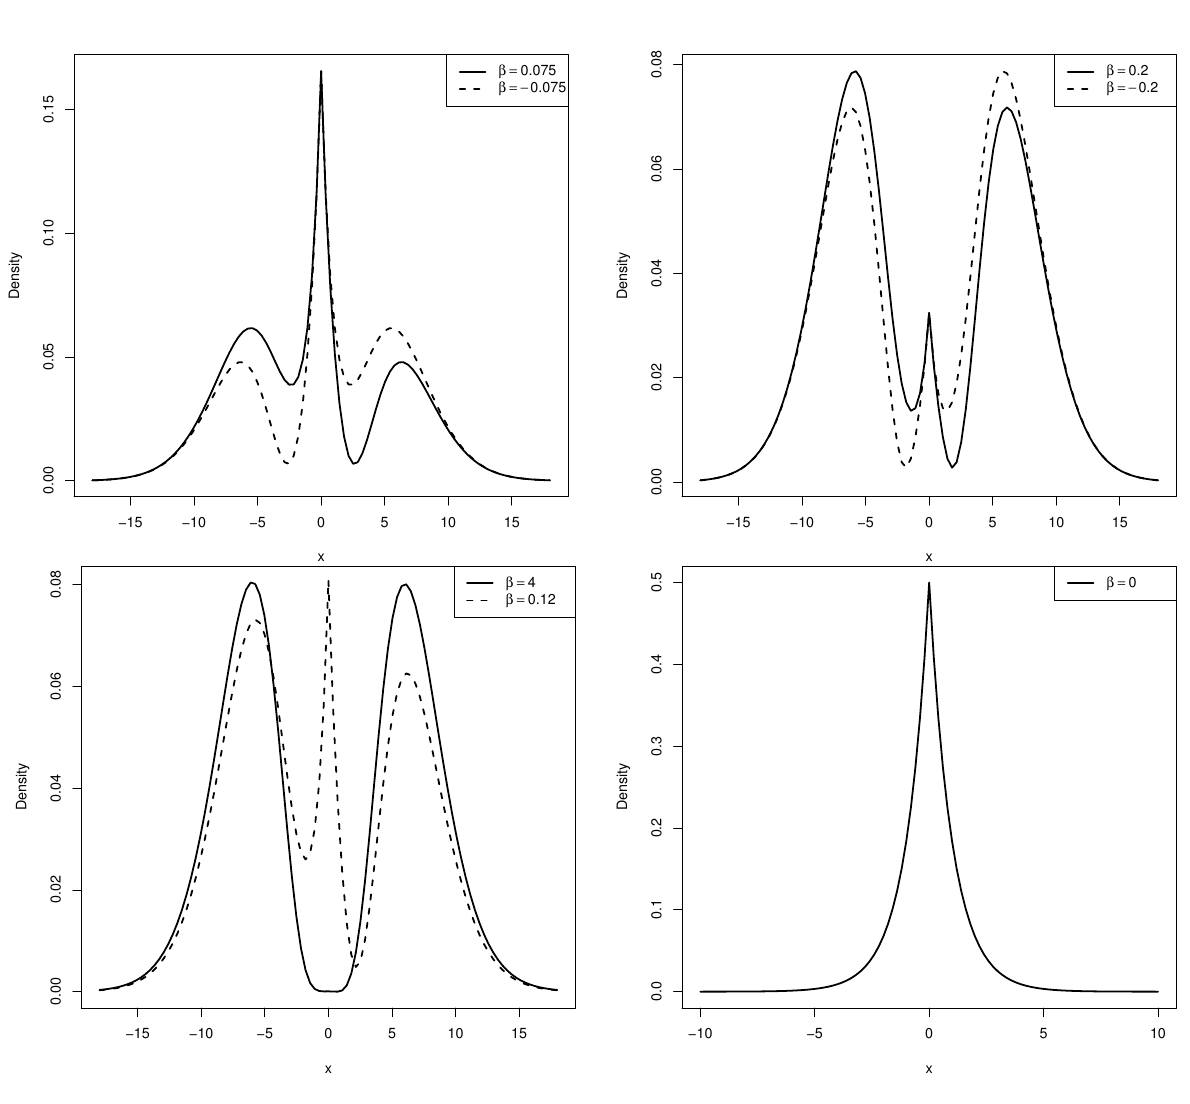
Figure 1. Probability density function of BSL (𝜷) for some selected values of 𝜷